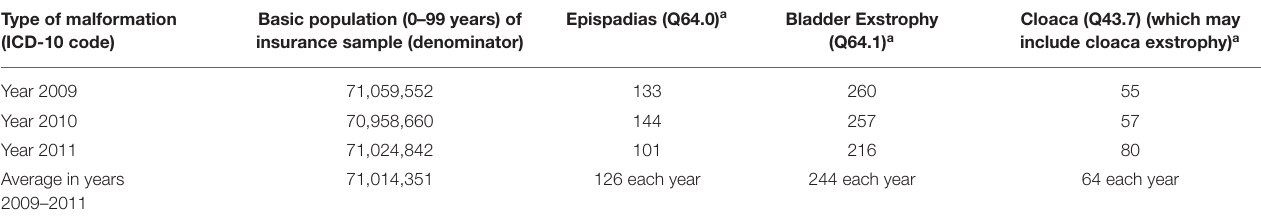
TABLE 1 | Inpatients with EEC, and due to small cell numbers no age and sex stratification. Type of malformation (ICD-10 code)